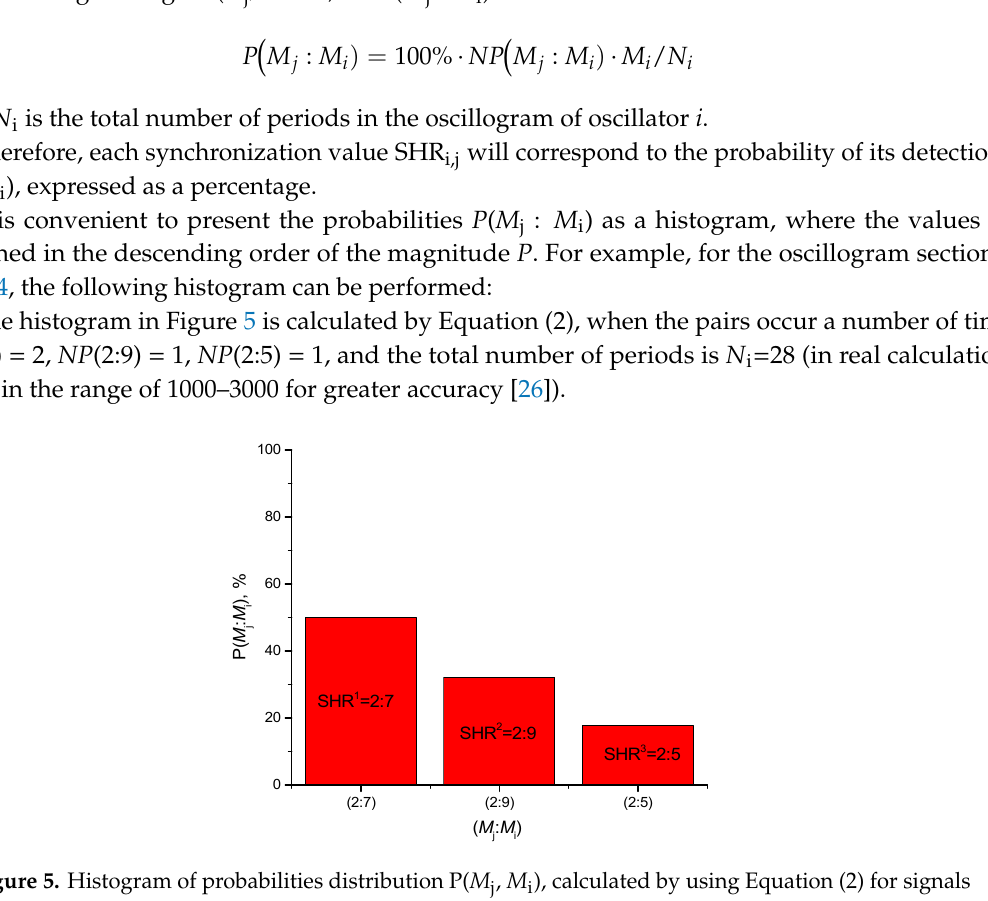
Figure 5. Histogram of probabilities distribution P( M j , M i ), calculated by using Equation (2) for signals of LE, shown in Figure 5.